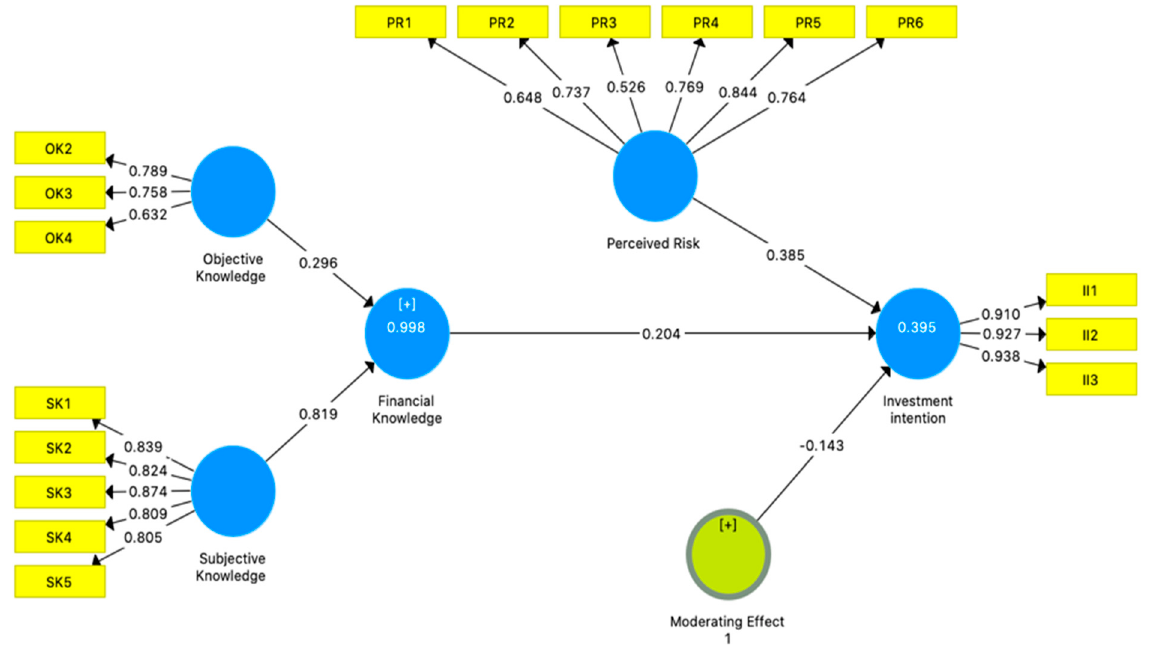
Figure 4. This study’s final structural model. Source: Outputs of statistical analysis using Smart PLS software considering the measurement model.